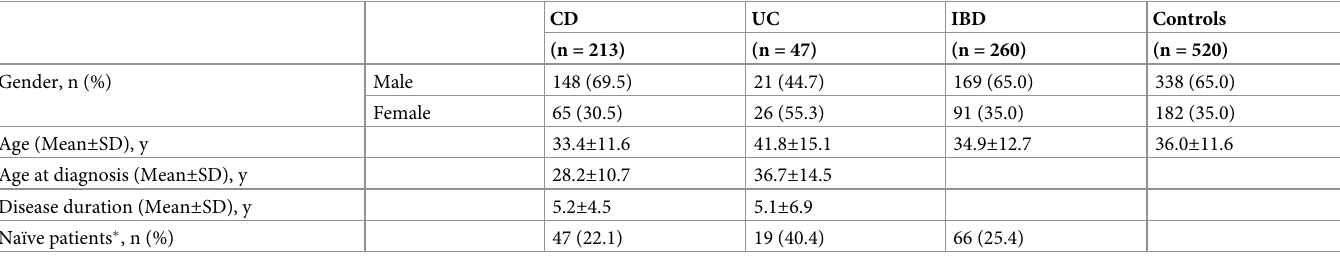
Table 1. Demographic and clinical